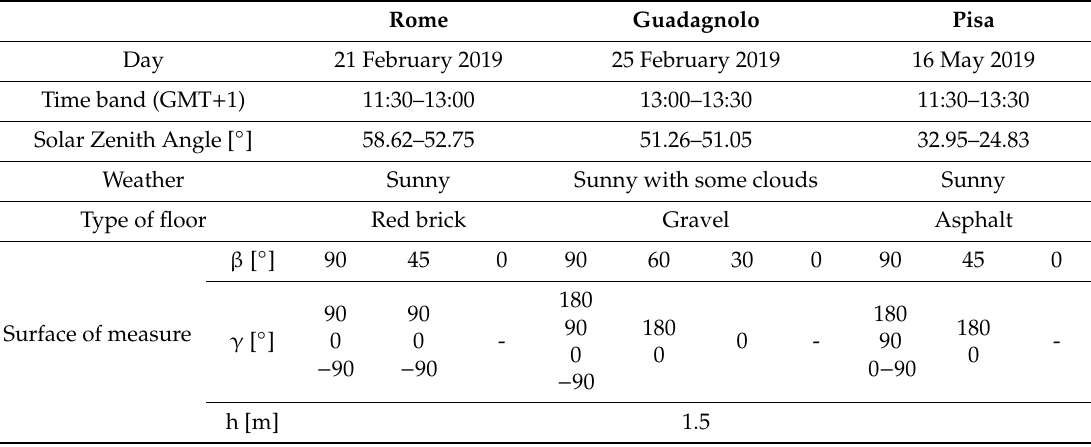
Table 6. Characteristics of the measurement activity for the three considered sites. Rome